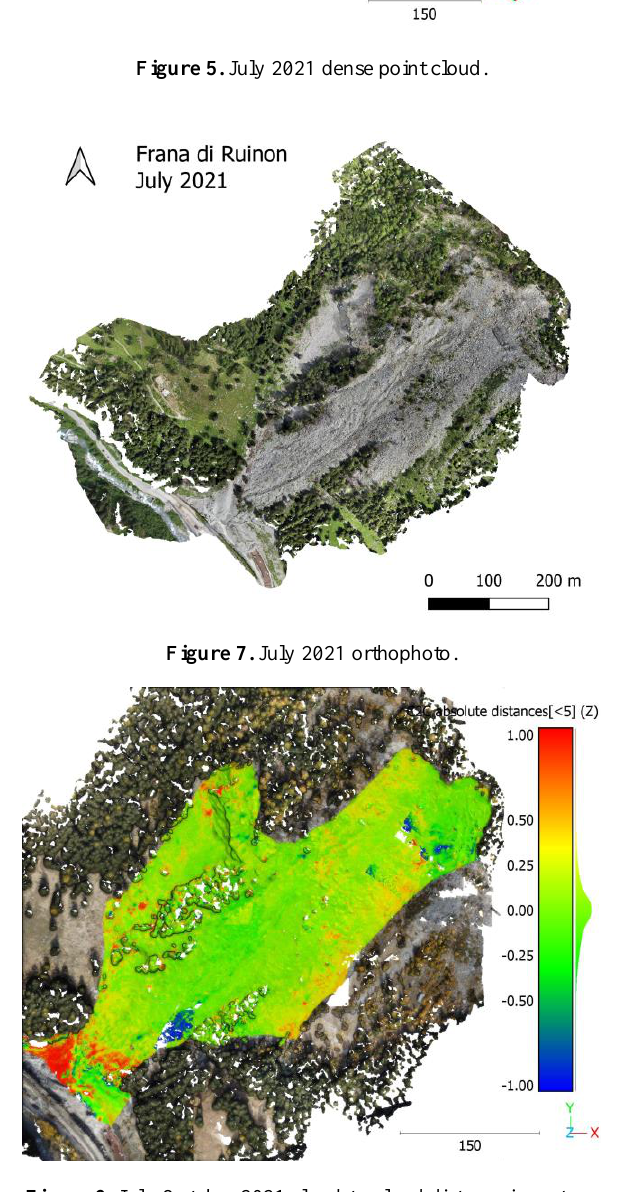
Figure 9. July-October 2021 cloud-to-cloud distance in meters. Figure 10. July-October 2021 M3C2 distance in